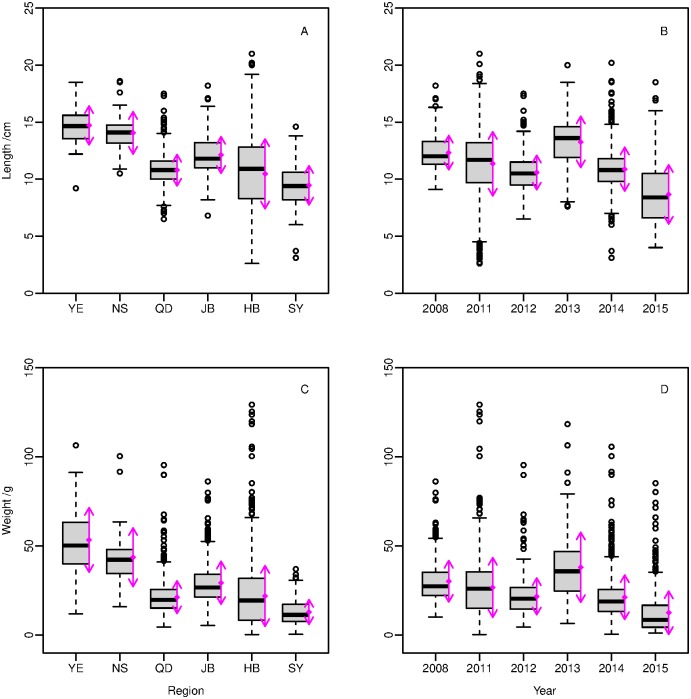
Length and weight of Yellow Croaker among regions and years.The boxes show the median (solid line) and the interquartile range. The plus symbols are indications of outliers in the data. Arrows in magenta show the mean and standard deviation. Abbreviations of regions were detailed in Table 1.